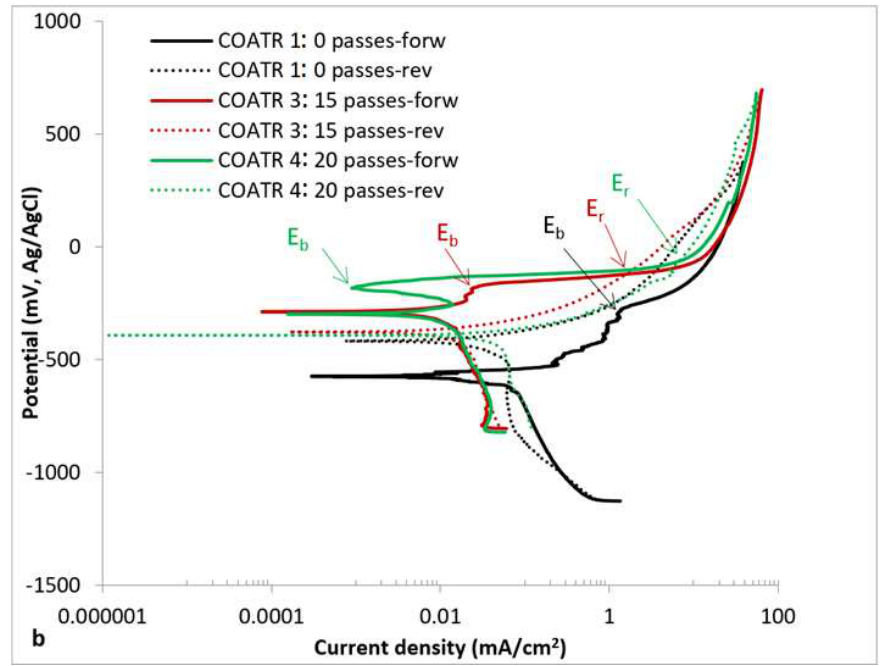
Figure 12. Effect of heat treatment of the coatings after thermal spraying on the cyclic polarization behavior of nickel aluminide coatings. ( a ) Forward polarization curves; ( b ) cyclic (forward and reverse) polarization curves (3.5% NaCl, 25 °C). Table 6. Electrochemical values of the coatings immersed in 3.5% NaCl at 25 °C: Effect of heat treatment.